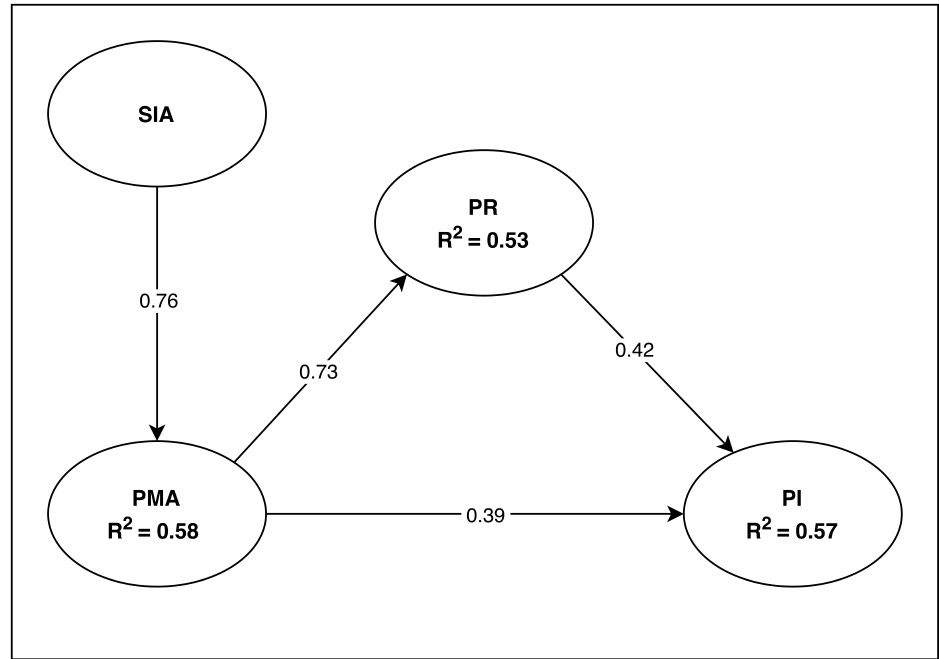
Figure 3. The Results of Indirect Structural Model: Standardized Path Coefficient